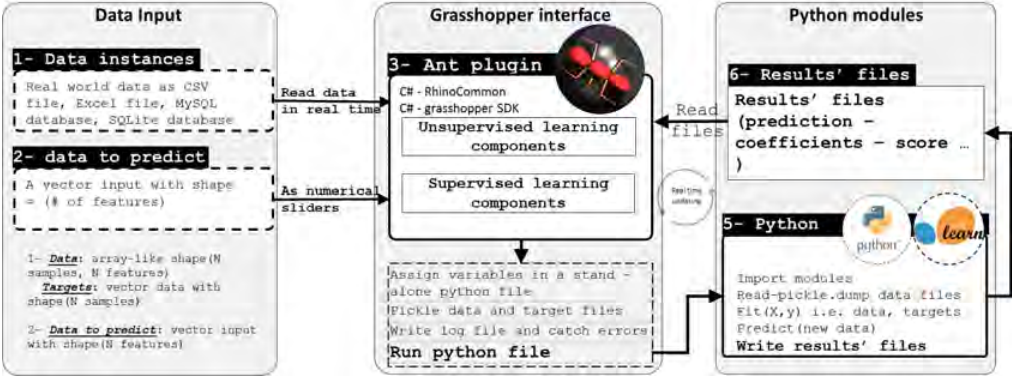
Figure 2. Structure of